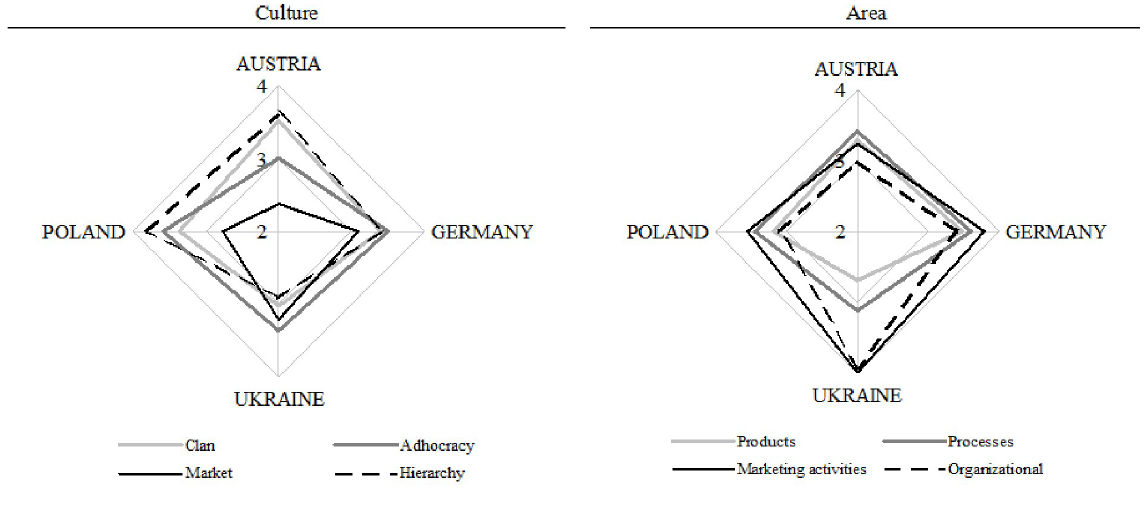
Fig 6. Type of culture favouring innovation and areas where innovation was introduced from 2015 to 2019 in the selected countries.